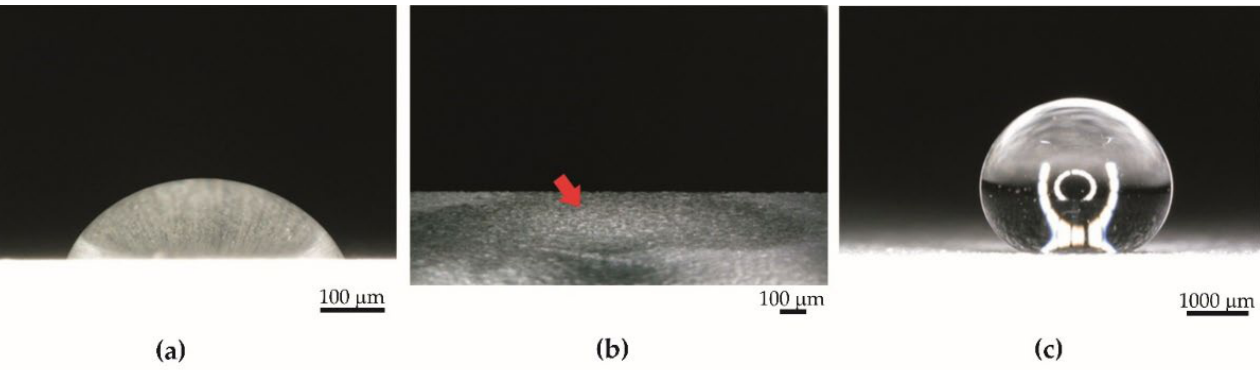
Figure 4. The surface of the specimen from Series 1 (basic anodization process): ( a ) mag. 10,000×: ( b ) mag. 100,000×, ( c ) AFM topography.